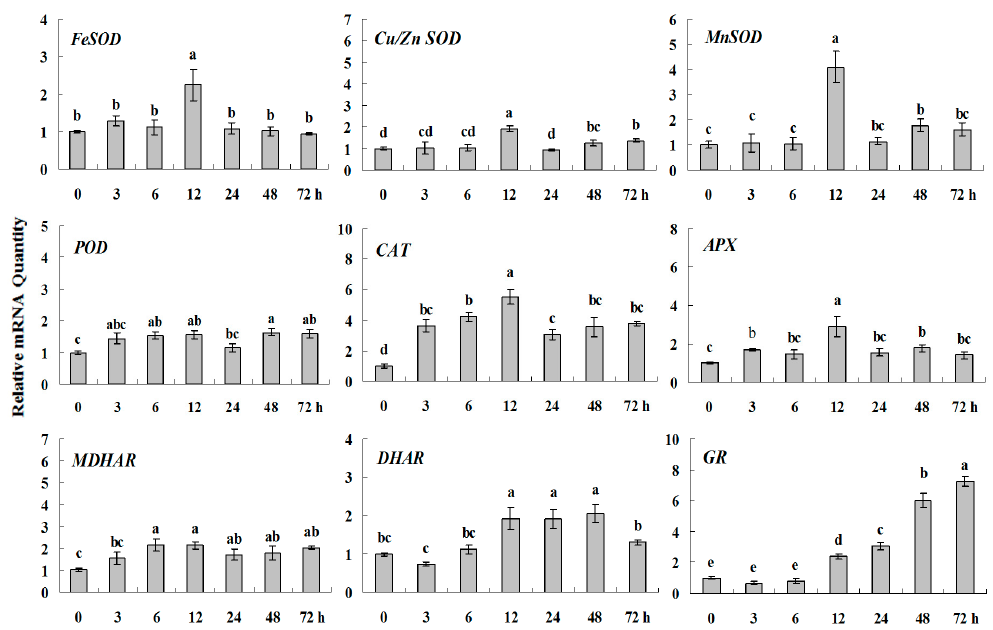
Figure 5. Quantitative real-time RT-PCR was used to analyze of ROS-scavenging enzyme genes expression during salt stress and normalized to β -Actin . White clover leaves were sampled after 0, 3, 6, 12, 24, 48 and 72 h treatment. Data represent means of three replicates. Error bars representing standard errors and the different letters above the bars represent significant difference ( p < 0.05). Molecules 2015 , 20 , page–page